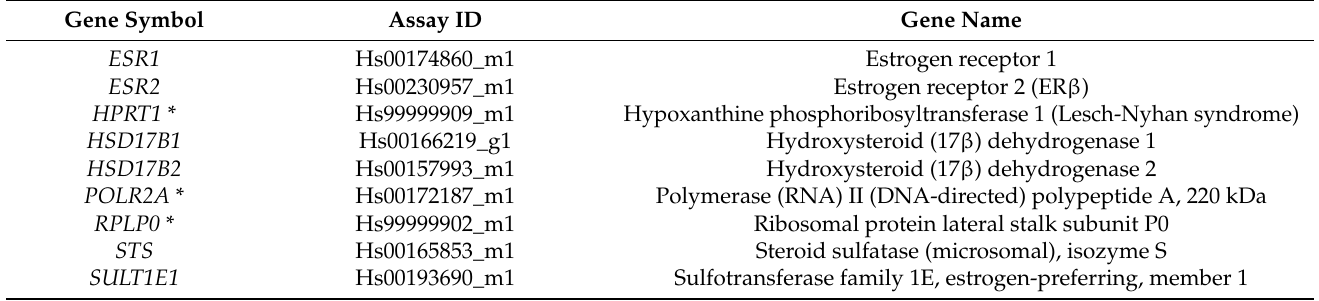
Table 1. TaqMan ® assays on demand for the genes investigated.